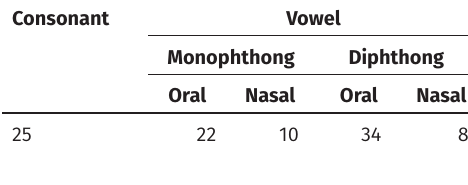
Table 3: Number of phones of each type in the List of